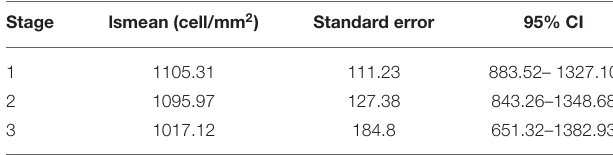
TABLE 3 | Estimated marginal mean of each